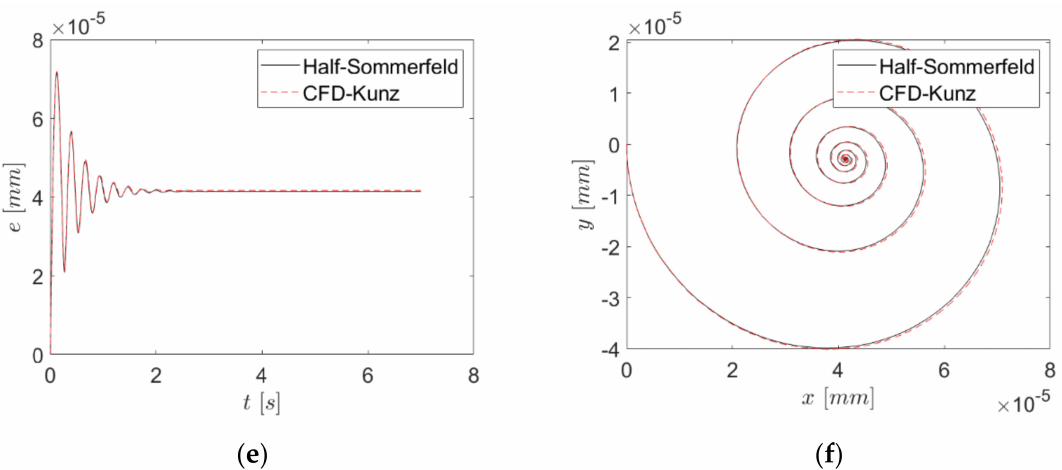
Figure 9. Trajectory of the journal ( b , d , f ) and damping ( a – c ) @1500 rad / s for di ff erent masses: top